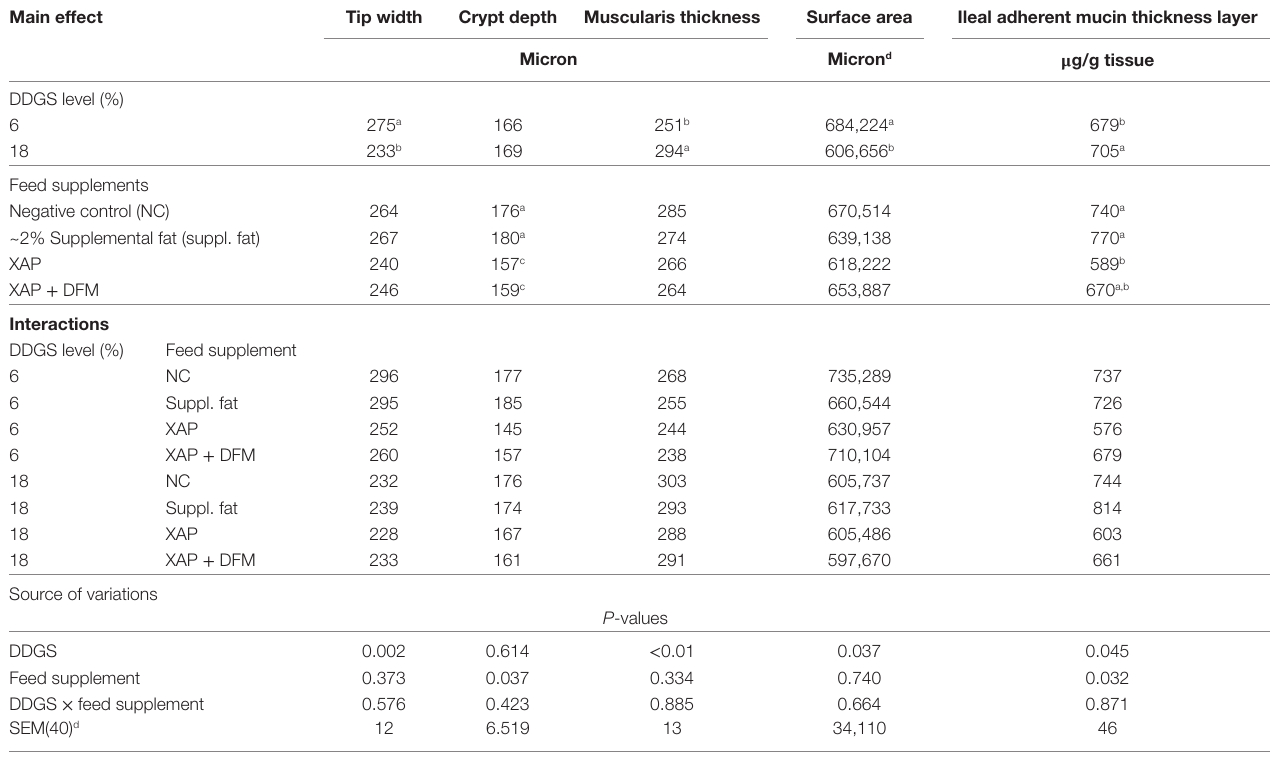
TaBle 4 | influence of dietary DDgs level, and XaP and DFM supplementation on the morphological measurements of jejunum villi and mucosa of turkey hens at 42 days.